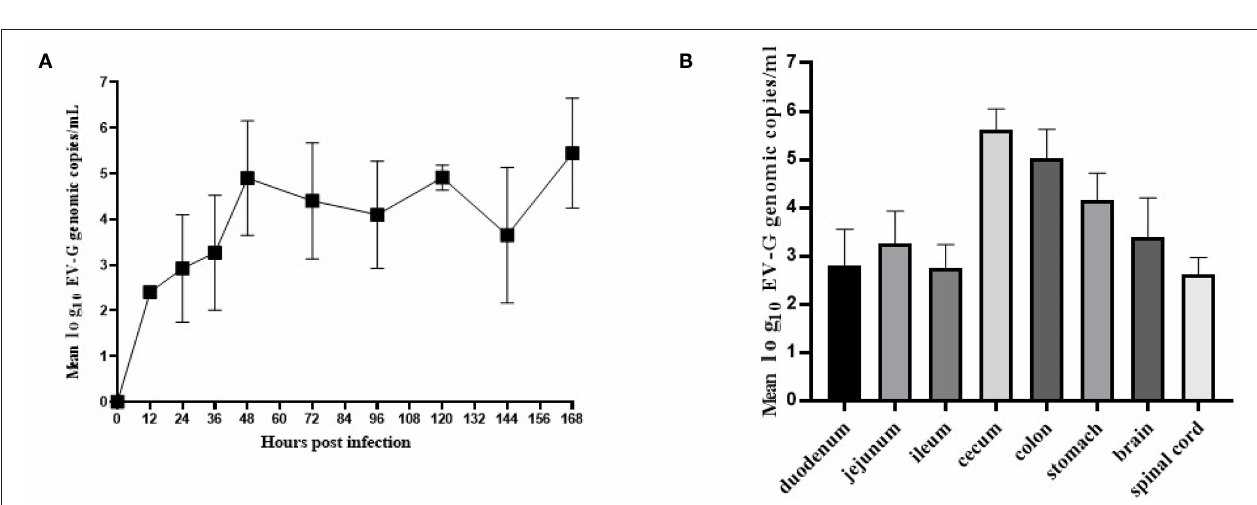
FIGURE 7 | The viral shedding in fecal swabs and the viral distribution in different tissues in EV-G infected piglets. The fecal swabs were collected from piglets at 0–168 hpi. The EV-G shedding in fecal swab samples from infected piglets were detected (A) . Intestinal segments and other tissues (stomach, brain, spinal cord) were collected at 7 dpi. The EV-G viral RNA loads were detected (B) . Each point or histogram shown are the mean values ± SD (error bars) from four